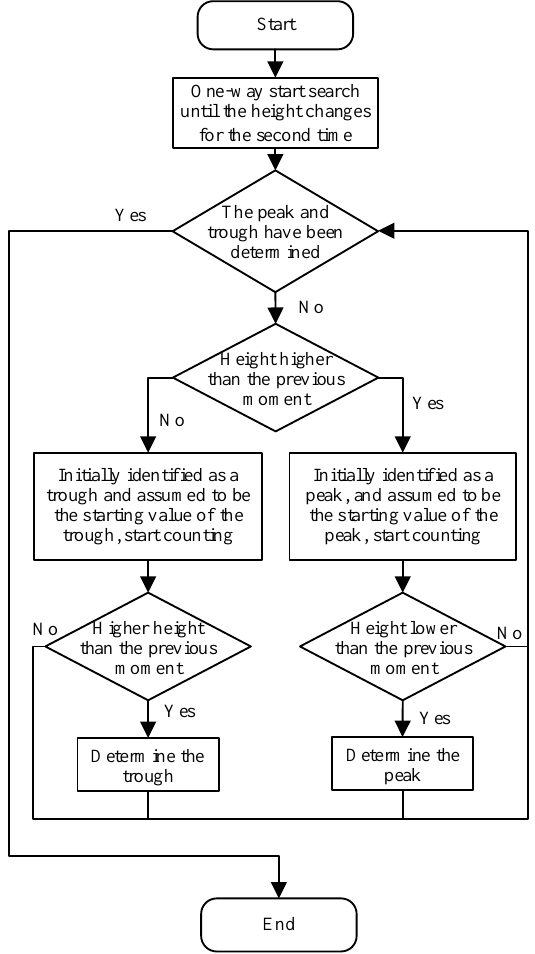
Figure 11. One-way extreme-value search algorithm.